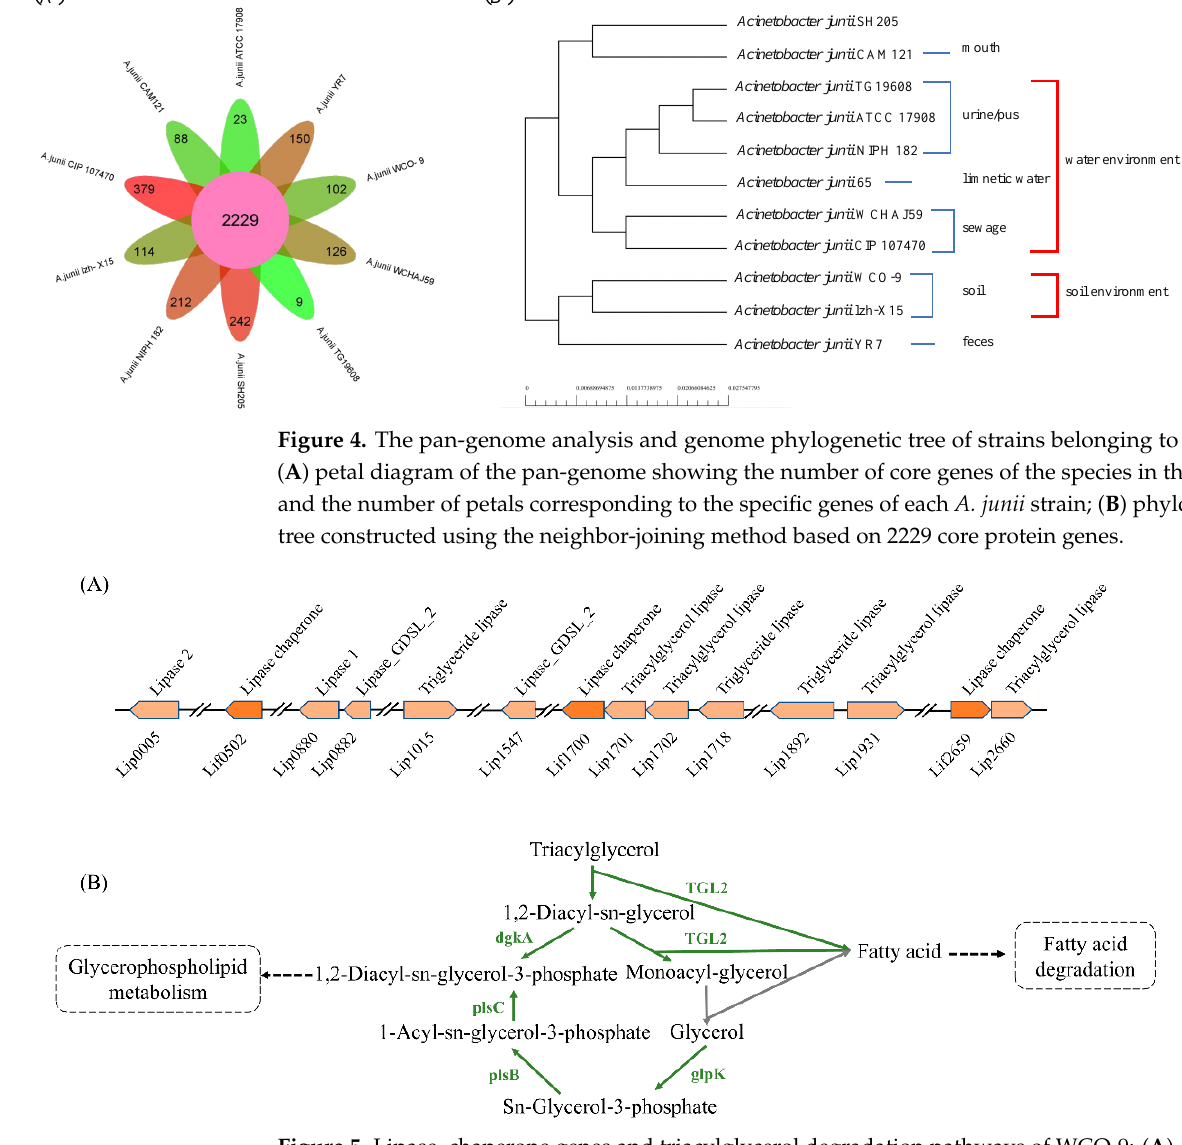
Figure 5. Lipase, chaperone genes and triacylglycerol degradation pathways of WCO-9: ( A ) distribution of lipase and chaperone genes in the genome of strain WCO-9; ( B ) triacylglycerol degradation pathway of strain WCO-9, the green arrows indicate the key metabolic pathway enzymes present in strain WCO-9.